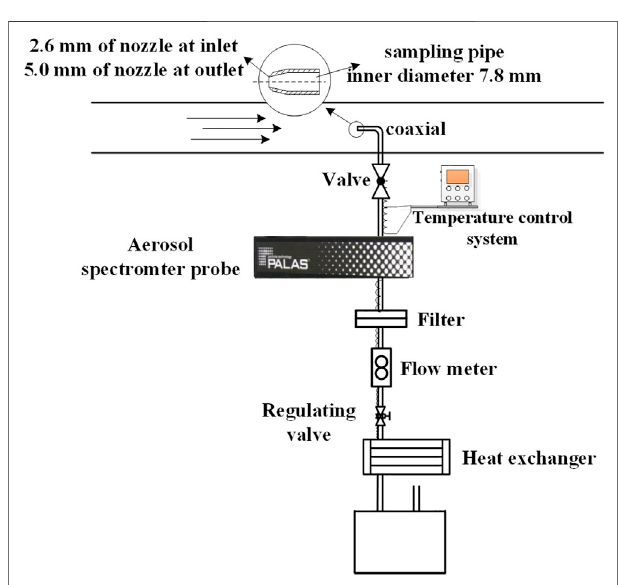
FIGURE 2 | Schematic of the aerosol concentration measurement